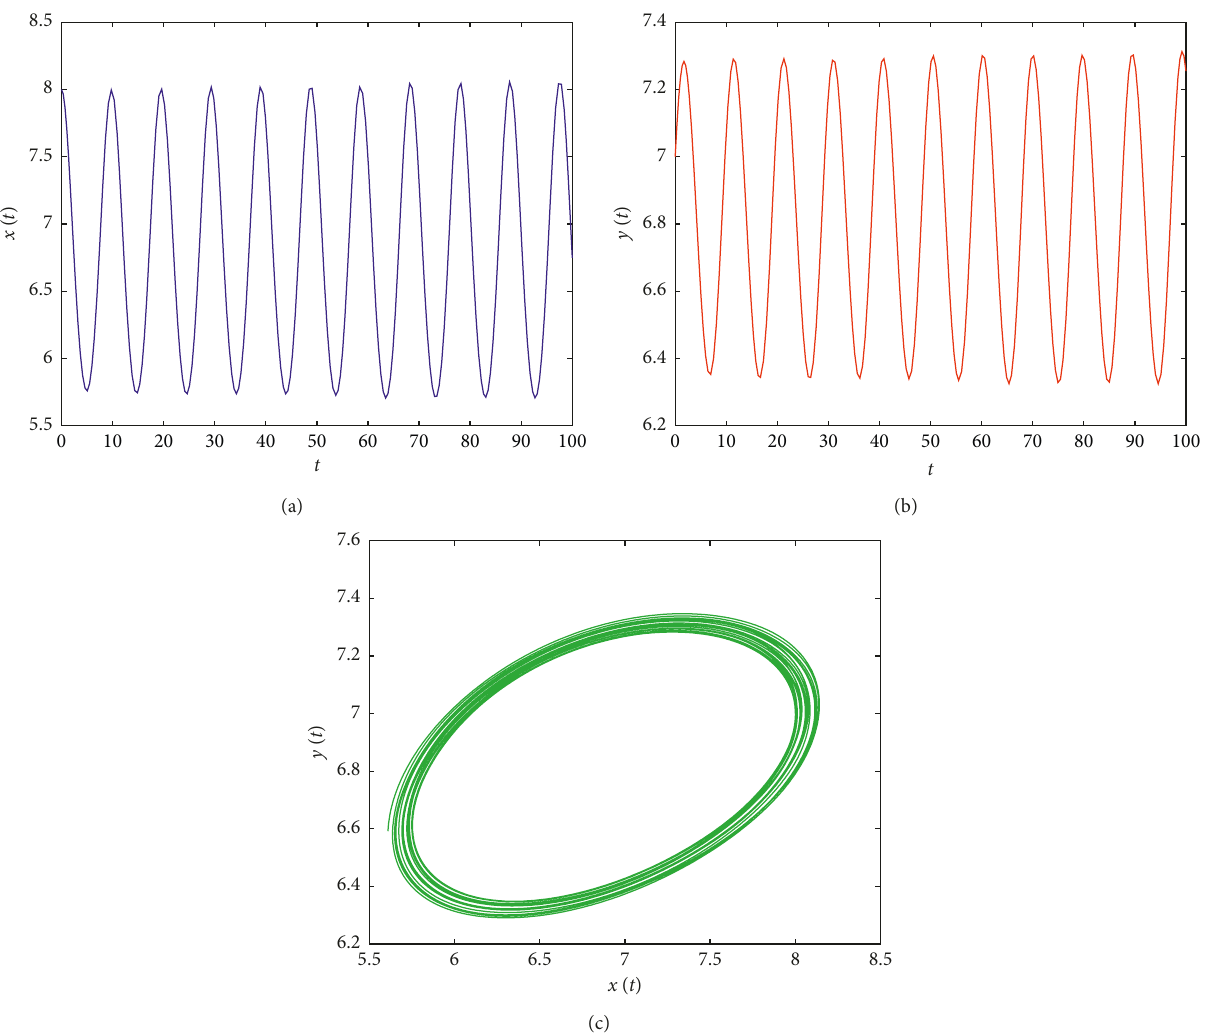
Figure 4: The time series and portrait phase of model (71) when u < Kr /4; here u � 2 ,K � 8 , r � 2 , and α � 0 . 2928. (a) The time series of x ( t ) ; (b) the time series of y ( t ) ; (c) the portrait